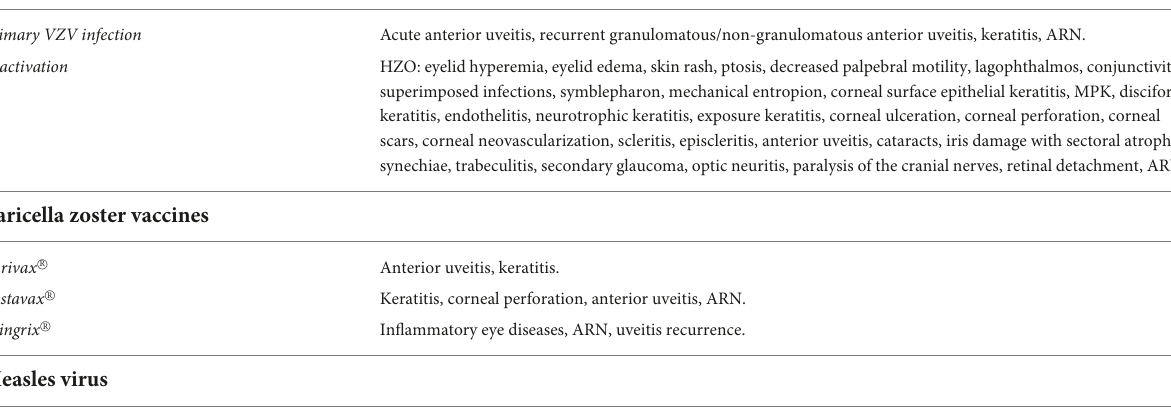
TABLE 1 Reported ocular complications of viral infections and corresponding vaccine. Varicella zoster